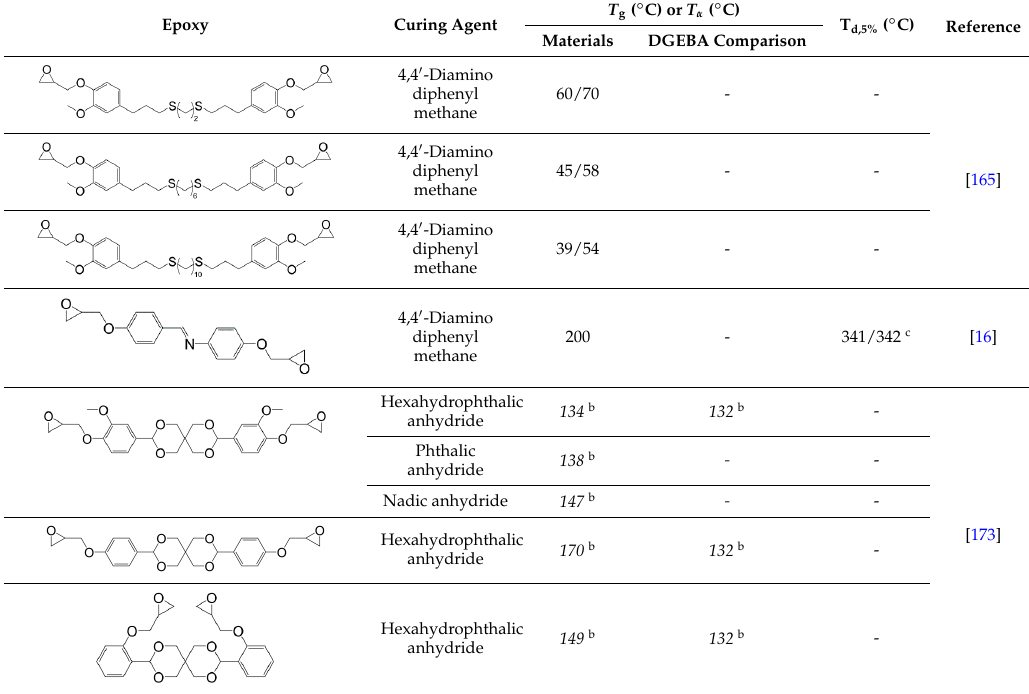
b T α measured by DMA at the maximum of T g (°C) or T α (°C) T g (°C) or T α (°C) T d,5% (°C) Reference Materials DGEBA Comparison T d,5% (°C) Reference Materials DGEBA Comparison